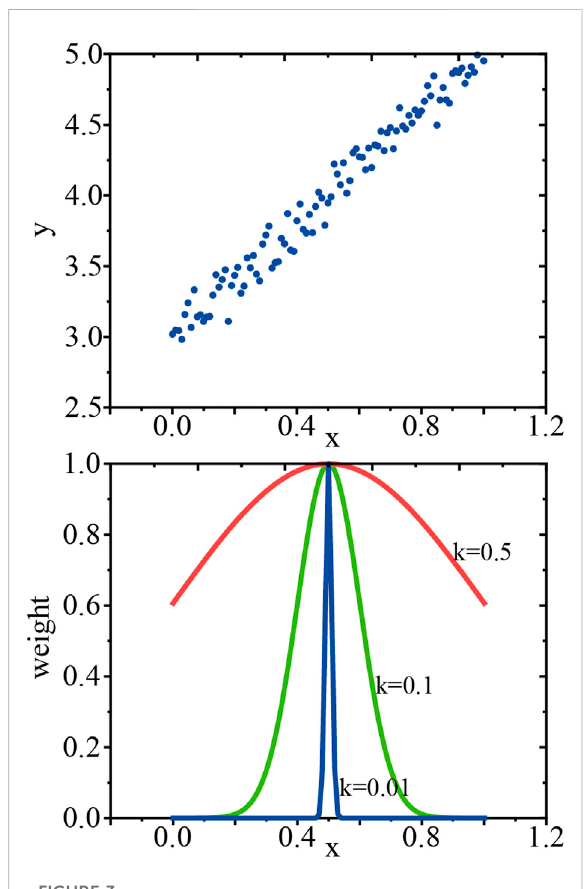
FIGURE 3 Relationship between parameter k and weights. The above panel represents the scatter plot of y and x; the bottom panel illustrates the changes in the weights of the points near the measurement point with the parameter